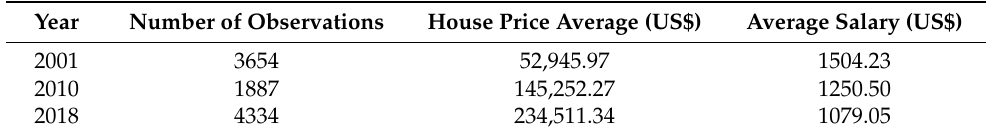
Table 3. Sample size and house prices in the CBA. Data from DGEyC [48] and compiled by the author of data from ‘Mercadolibre’ and